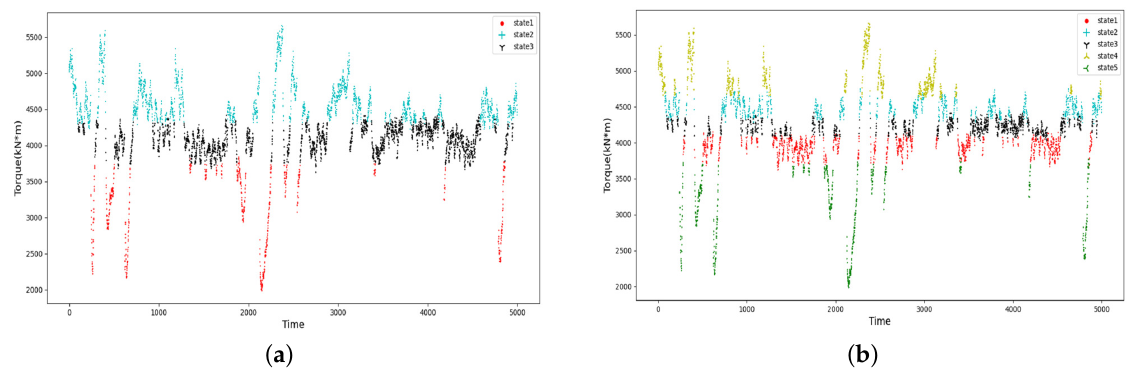
Figure 5. The hidden states of torque: ( a ) under N s = 3; ( b ) under N s = 5.